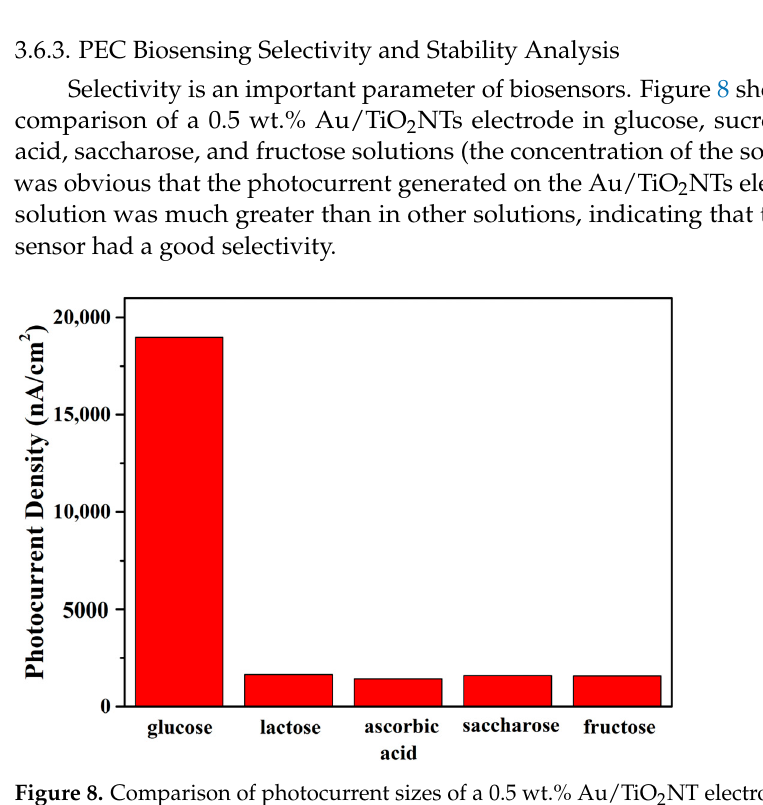
Table 1. Comparison of analytical characteristics of different glucose sensors.